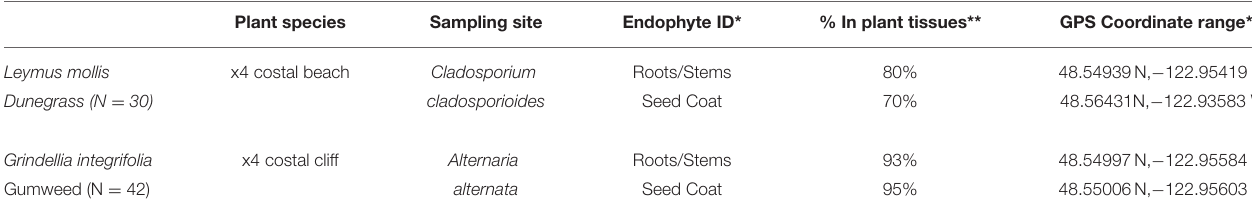
TABLE 4 | Plant endophyte analysis in low salt (dunegrass) and high drought (gumweed) stress habitats at Cedar Rocks